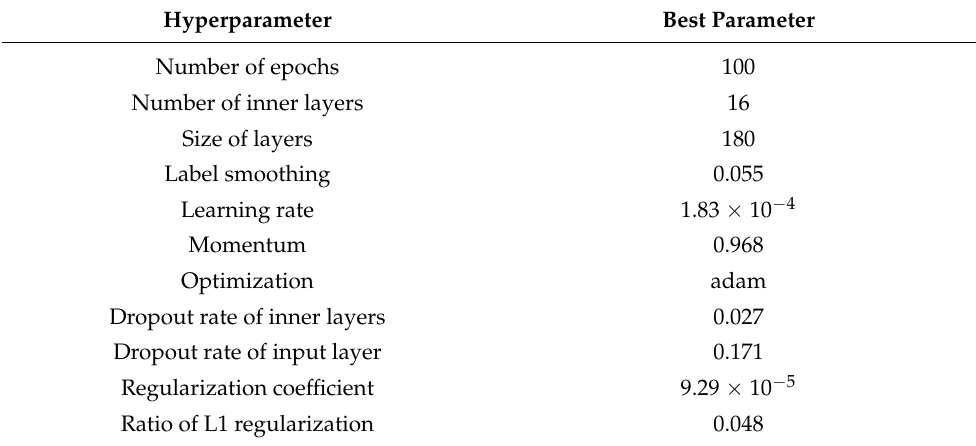
Table 2. The best hyperparameters of the pointwise linear model for classification of MSA